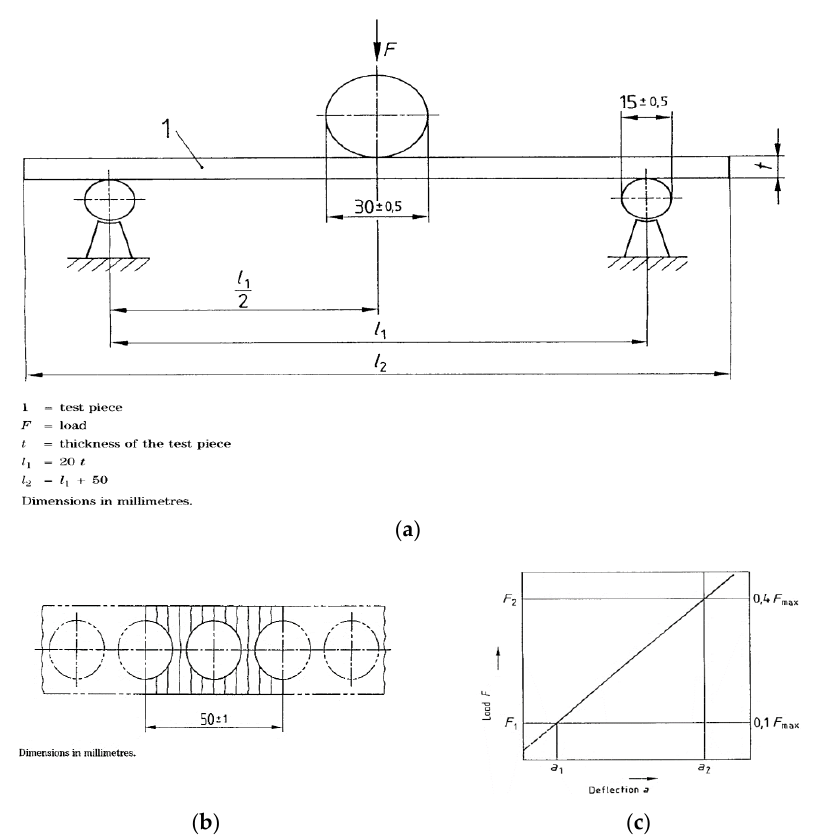
Figure 9. ( a ) Arrangement of the bending apparatus, ( b ) Cross section of tubular boards, ( c ) Load-deflection curve within the range of elastic deformation.